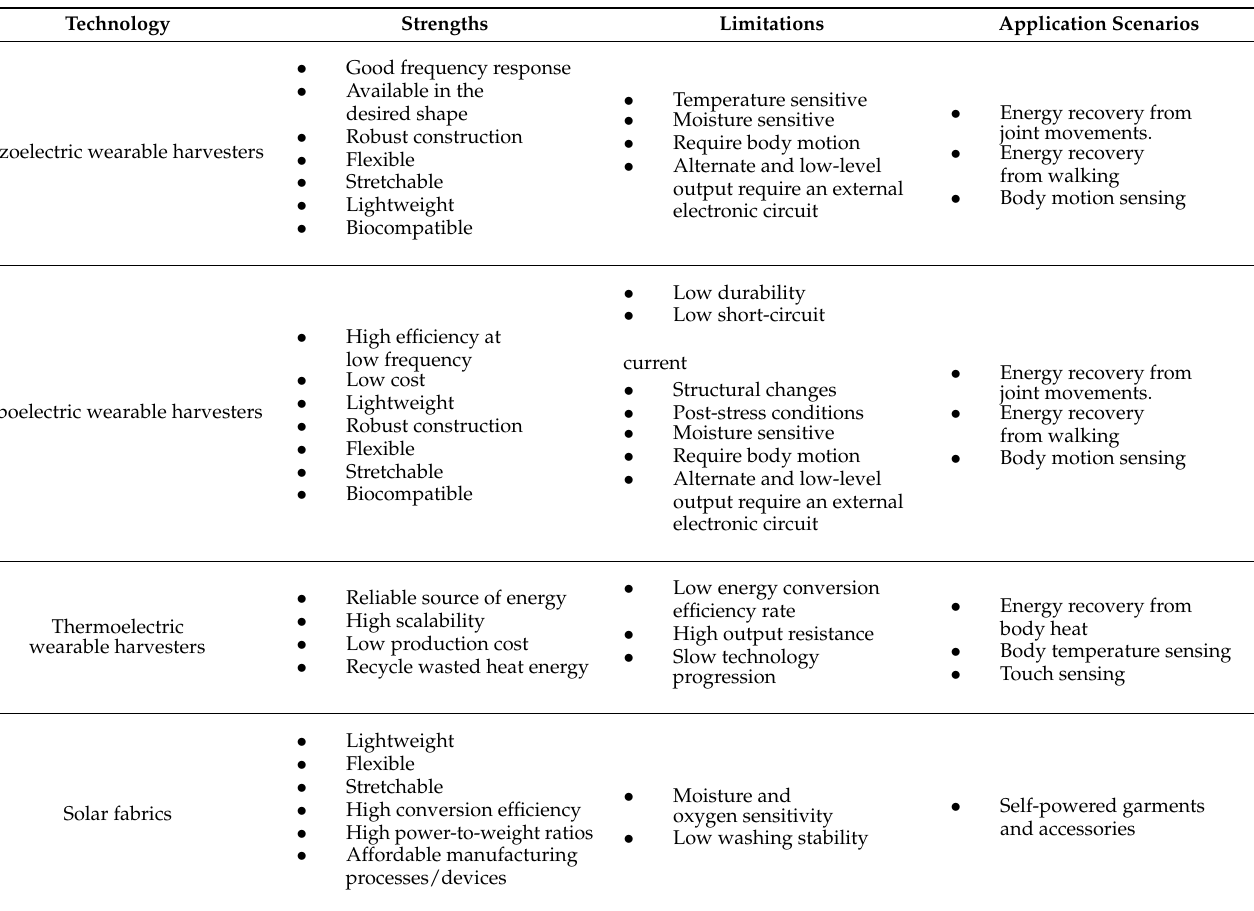
Table 8. Summarizing table reporting the strengths and limitations of discussed energy harvesting technologies, as well as their application